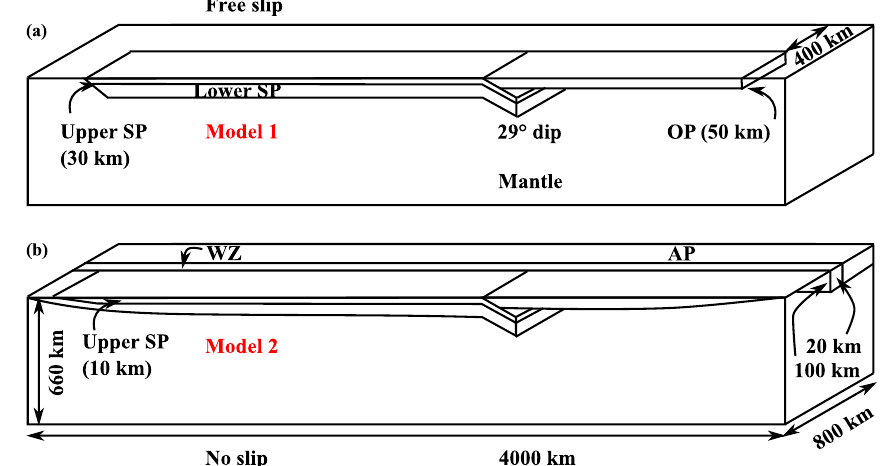
Figure 14. Three-dimensional subduction model setups (also, see Table 7). (a) Model 1: a free overriding plate (OP) and a subducting plate (SP) with a trench at x = 2400km. At start-up, the slab extends 200km into the mantle (measured vertically) at an angle of 29 ◦ . The 100km thick SP consists of two compositional layers, the OP of only one composition. All boundaries are free slip, except the no-slip bottom boundary. (b) Model 2: a 58 . 8Myr old adjacent plate (AP) is added, separated from the OP and SP by a weak zone (WZ) of 20km width. The initial temperature distribution of the SP and OP is based on the plate cooling model dependent on age, which increases from the ridge situated at the left, respectively right, vertical domain boundary, up to an age of 16Myr for the OP and 60Myr for the SP, resulting in thicknesses of 50 and 100km at the trench, respectively. An adiabat of 0 . 25Kkm − 1 is prescribed in the mantle. The bottom temperature is fixed at 1728K, the top at 293K. Table 8. Three-dimensional subduction model parameters (based on Hirth and Kohlstedt, 2003, and Ranalli, 1995). Parameter Mantle OP Mantle SP